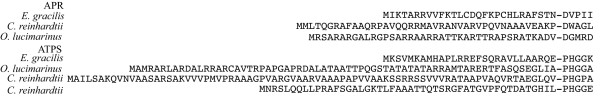
N terminal regions of ATPS and APR from E. gracilis along with their chlorophyte relatives C. reinhardtii and O. lucimarinus, showing mitochondrial targeting sequences in Euglena and plastid targeting sequences in the chlorophytes. The start of conserved sequence is indicated by a dash.